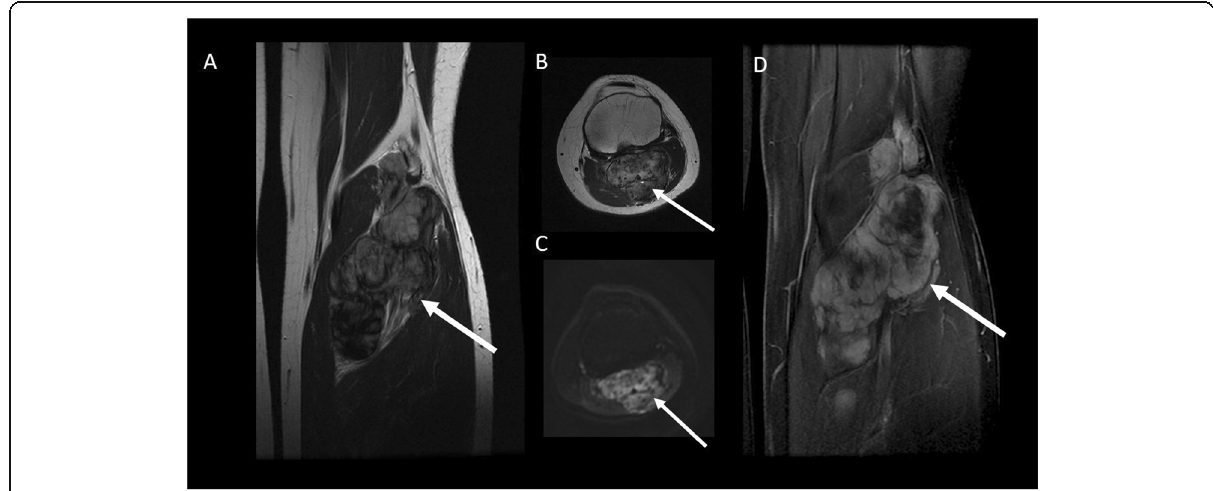
Fig. 5 A 24-year-old female patient with DT of the popliteal fossa (arrow). T2-wi (coronal ( a ) and axial ( b ) plane) showed a soft tissue mass with a heterogeneous hyperintense signal with internal whirling or band-like low-signal intensity. The lesion is characterized by mild restriction on diffusion weighted images sequences ( c ). After contrast enhancement (T1 in d ), the lesion was characterized by a peripheral contrast